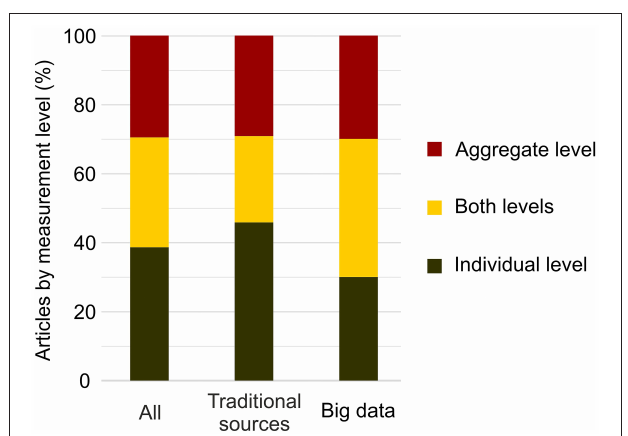
FIGURE 9 | Distribution of articles by activity space measurement level in all studies ( n = 44), and separately in studies using traditional data sources ( n = 24) and big data sources ( n =